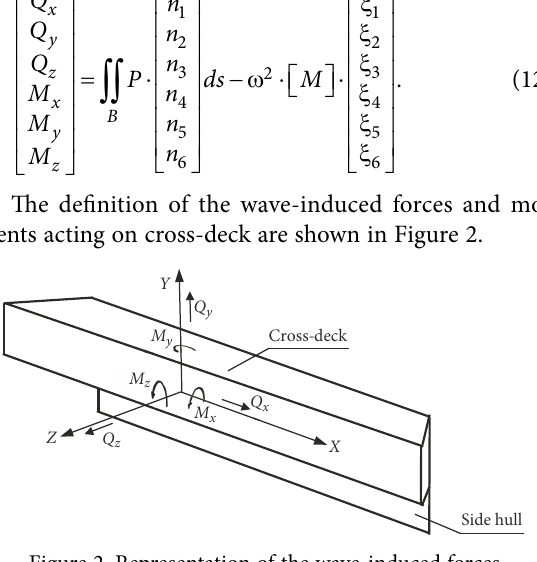
Figure 2. Representation of the wave-induced forces and moments acting on